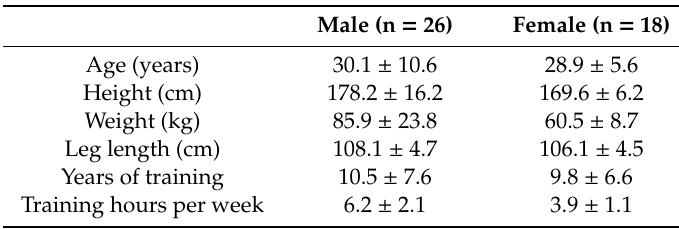
Table 1. Descriptive characteristics.